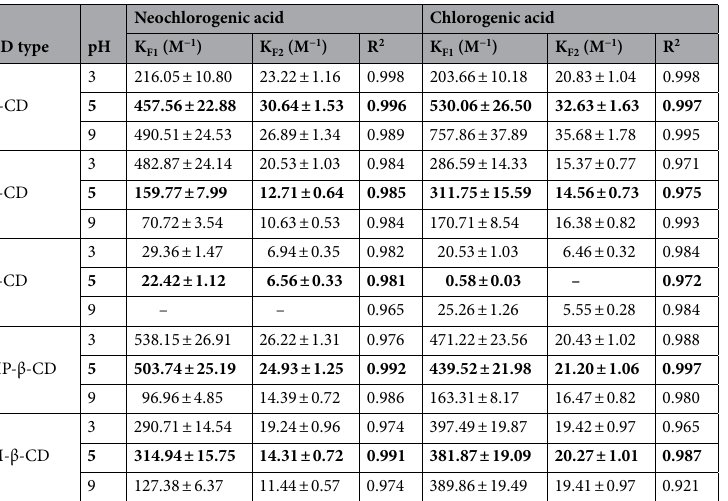
Table 1. Experimental encapsulation constants (K F1 and K F2 ) and correlation coefficients (R 2 ) arising from Eq. (3) (25 °C pH 3, 5 and 9). T-test (significance of p <